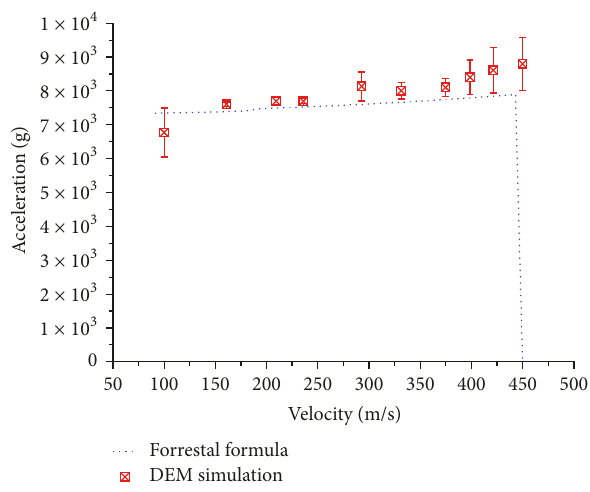
Figure 13: History of penetration acceleration as penetration veloc- ity.